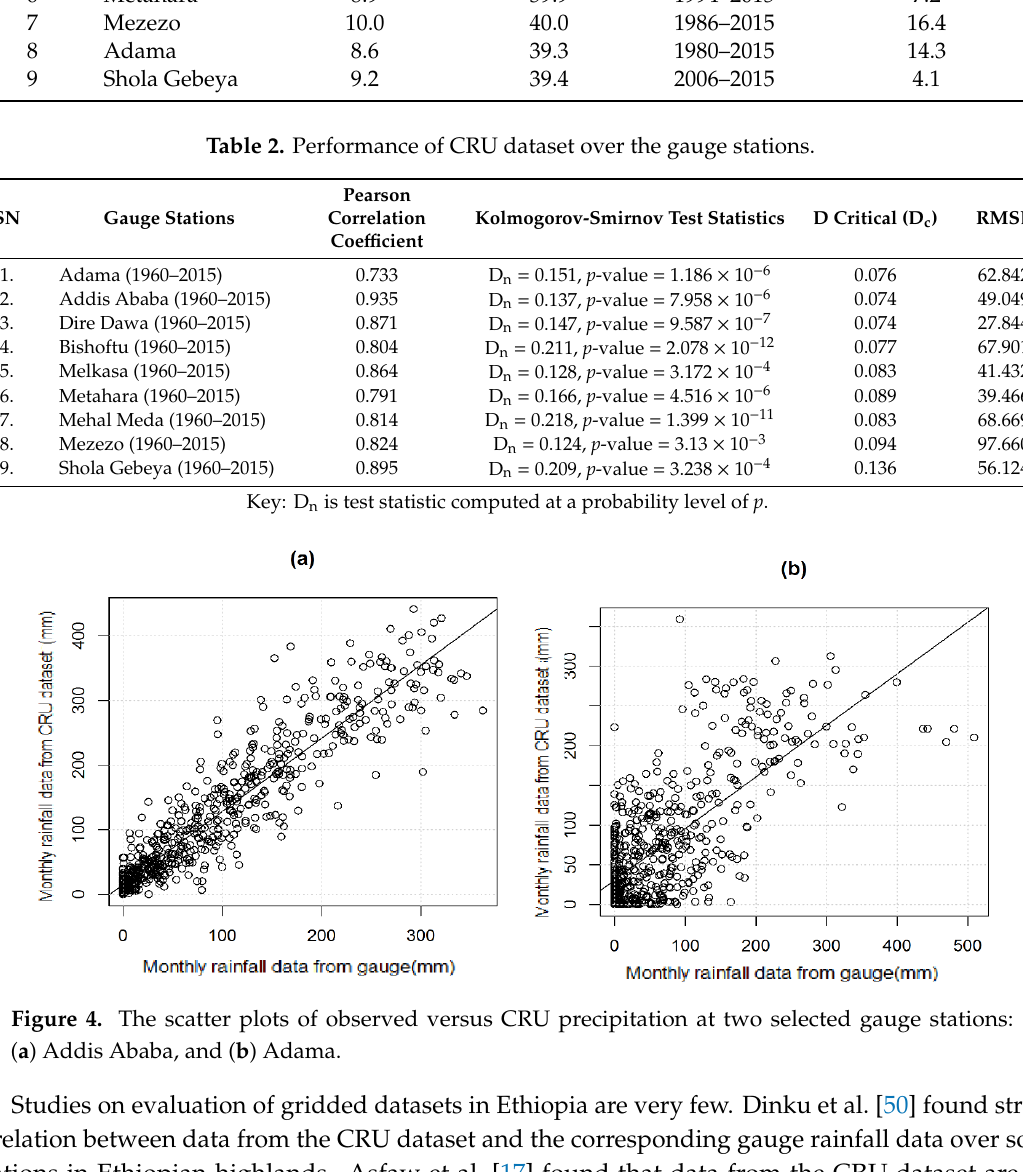
Figure 4. The scatter plots of observed versus CRU precipitation at two selected gauge stations: ( a ) Addis Ababa, and ( b ) Adama.